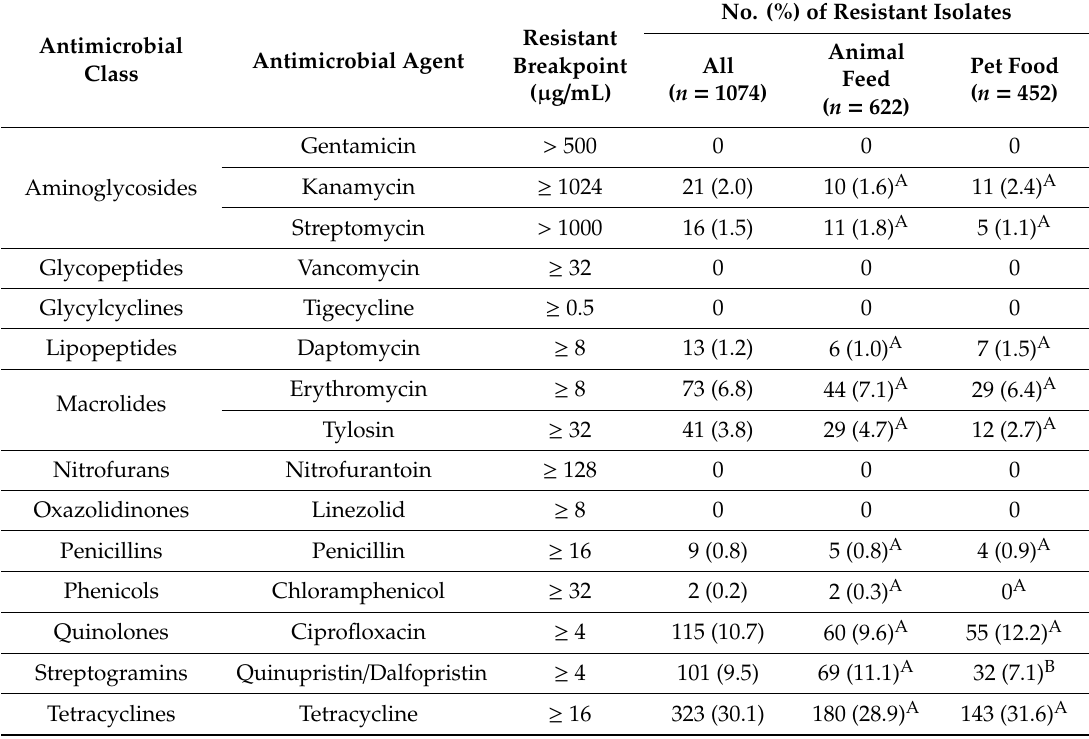
Table 3. AMR profiles among 1074 Enterococcus isolates by animal food